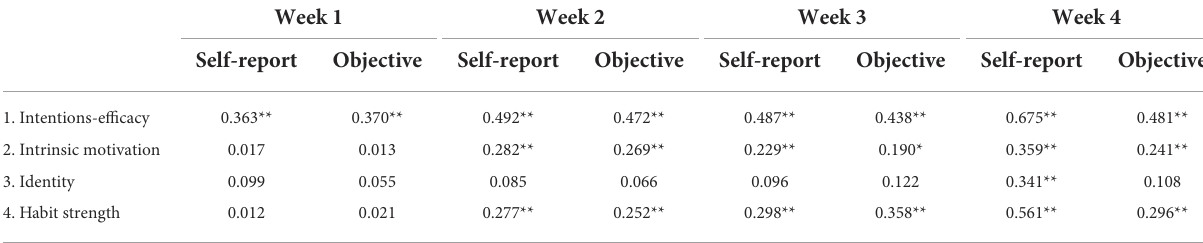
TABLE 1A Correlation results for calcium supplementation variables.